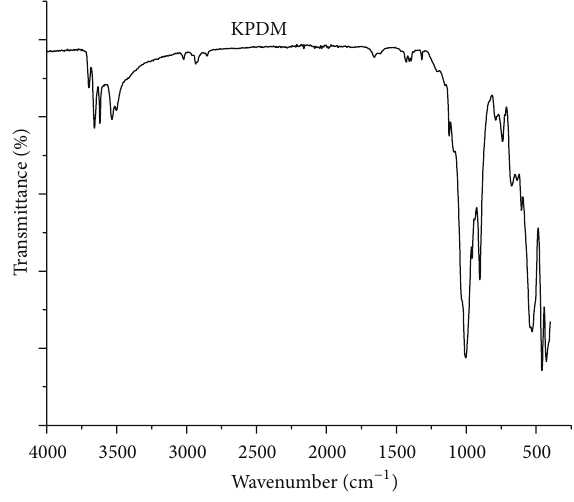
Figure 8: ATR-FTIR spectrum of KPDM.